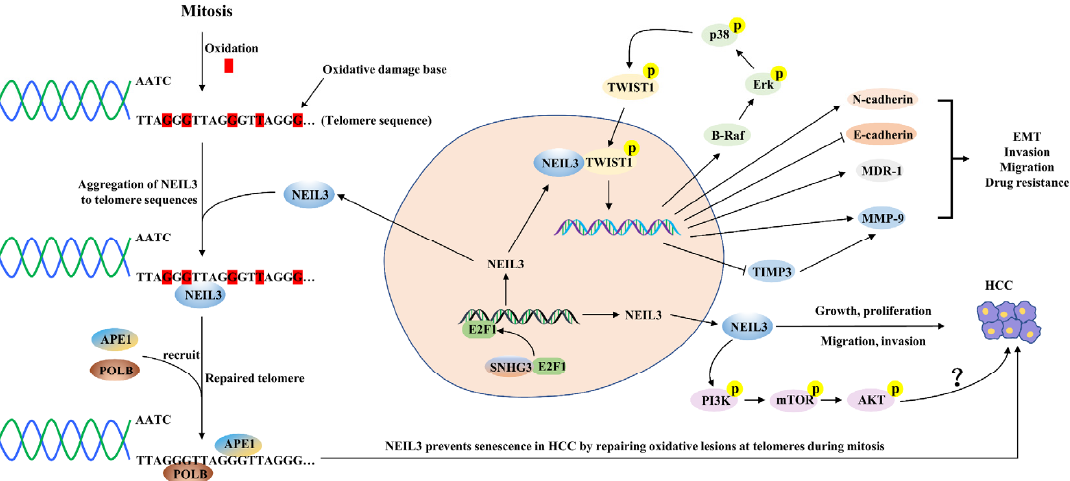
Figure 3. A schematic diagram of the mechanisms by which NEIL3 promotes HCC progression. SNHG3 interacts with E2F1 and enhances the binding ability of the E2F1 and NEIL3 promoter, thus promoting NEIL3 overexpression. NEIL3 promotes the malignant progression of HCC through the following mechanisms: (1) repairing telomere damage in HCC; (2) promoting EMT, invasion, lung metastasis and drug resistance by enhancing the phosphorylation level of TWIST1; and (3) promoting HCC cell proliferation possibly by activating the PI3K/AKT/mTOR axis.